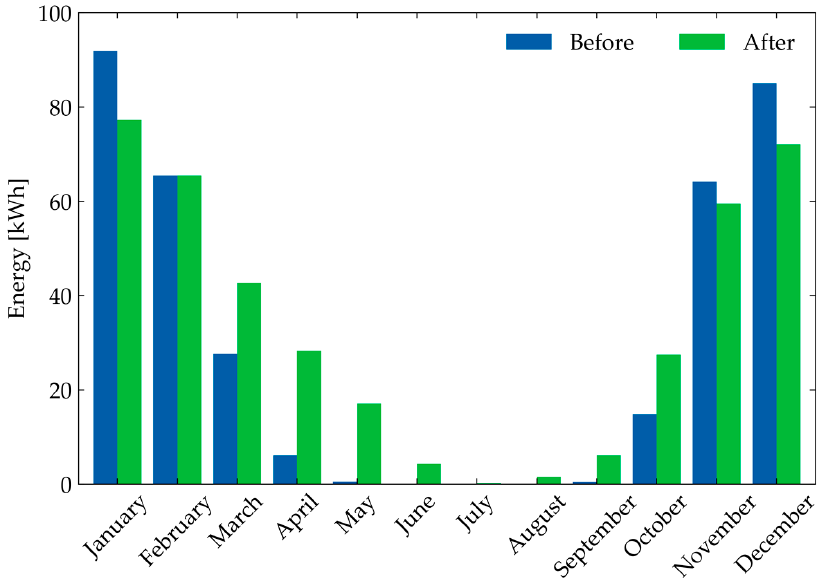
Figure 8. Heating energy load of the Welsh site room before and after the Figure 8. Η eating energy load of the Welsh site room before and after the renovation.